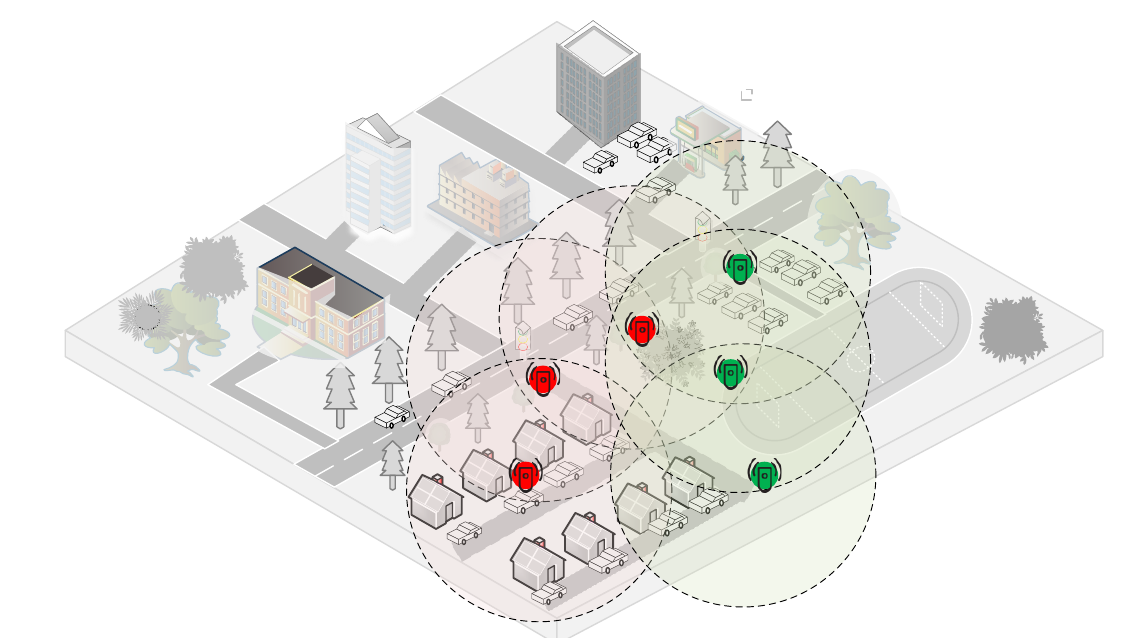
Figure 5. Smart IoT environment depiction of two groups of sensors which sponsors coverage (red) for each other (green). In each group, sensors set their priority for sensing in a particular area. Let us take the case of three red sensors in Figure 6 which are depicted by sensors - green, and red in Figure 6. Sensors in a group sense in rounds. In the first round, a sensor sponsors sensing coverage to other sensors, and the recipient becomes a sponsor in the next round. In this way, overlapping of the sensing region is avoided (cf. Figure 6). For example, the blue and red sensors sponsor coverage to each other’s.